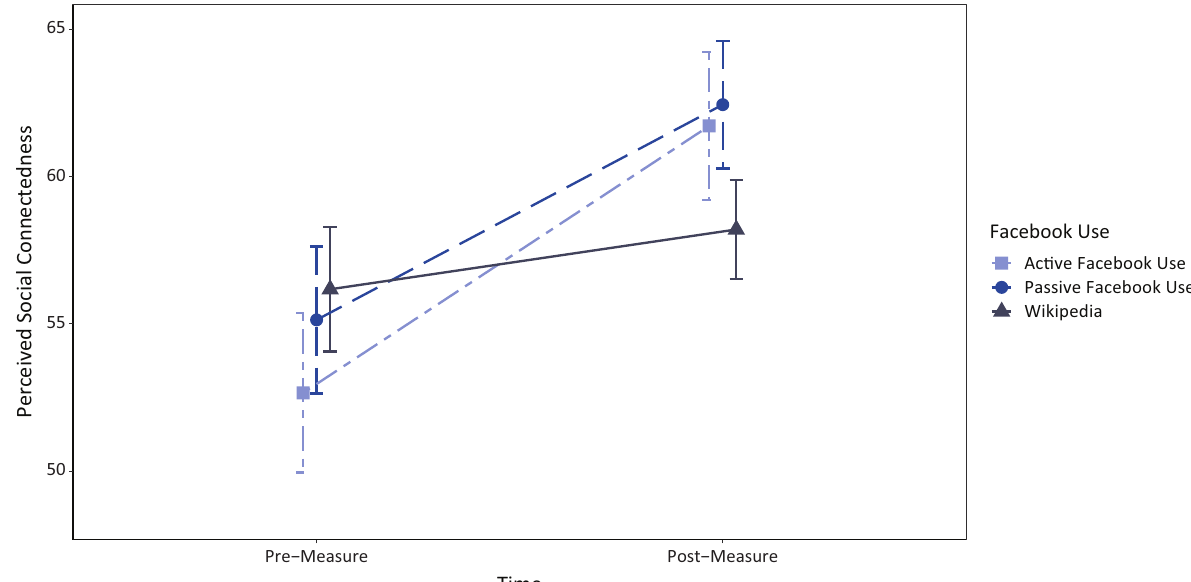
Figure 1. Mean Perceived Social Connectedness per Condition of Facebook Use Over Time for Experiment 1. Note: Standard errors are represented by error